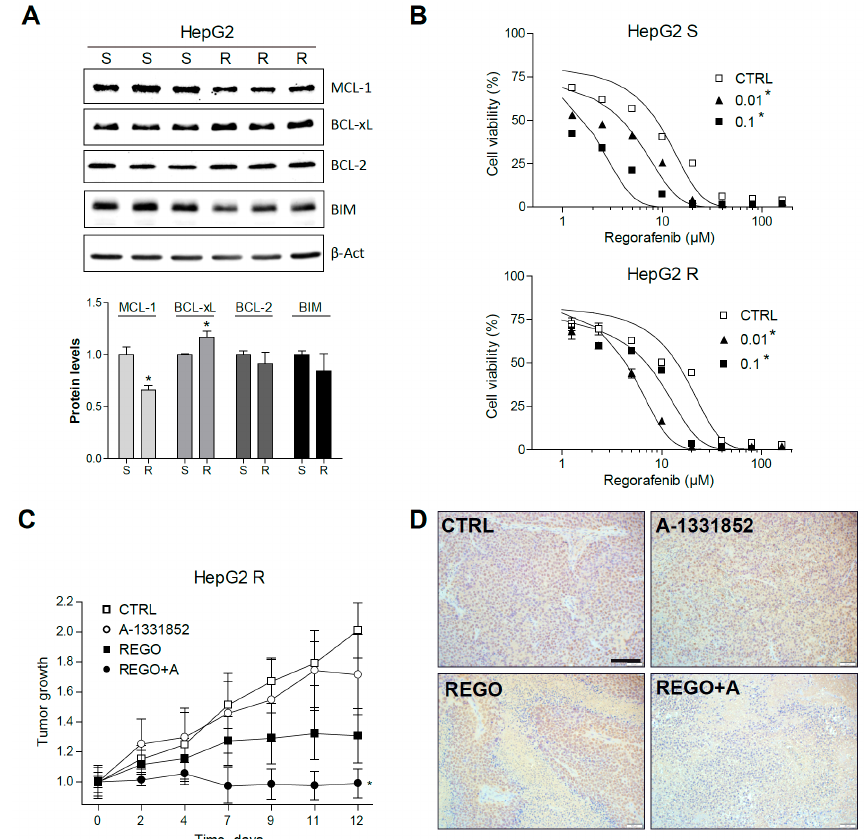
Figure 7. Regorafenib-resistant HepG2 cells, exhibiting mRNA changes in BCL-xL and MCL-1, are re-sensitized to regorafenib by A-1331582. ( A ) Representative Western blot images of MCL-1, BCL-xL, BCL-2, BIM, and β -Actin protein levels in S and R HepG2 cells. * p < 0.05 vs. sensitive cells. ( B ) E ff ect of A-1331852 (A, 0.01 or 0.1 µ M) on S and R HepG2 cells. * p < 0.05 vs. control cells. ( C ) Subcutaneous growth of R HepG2 cells in mice treated orally with A-1331852 (25 mg / kg) and regorafenib (30 mg / kg) for 2 weeks (n = 4). ( D ) Representative images of PCNA expression in tumors from HepG2 R CDXs (scale bar, 100 µ m). * p < 0.05 vs. vehicle-treated